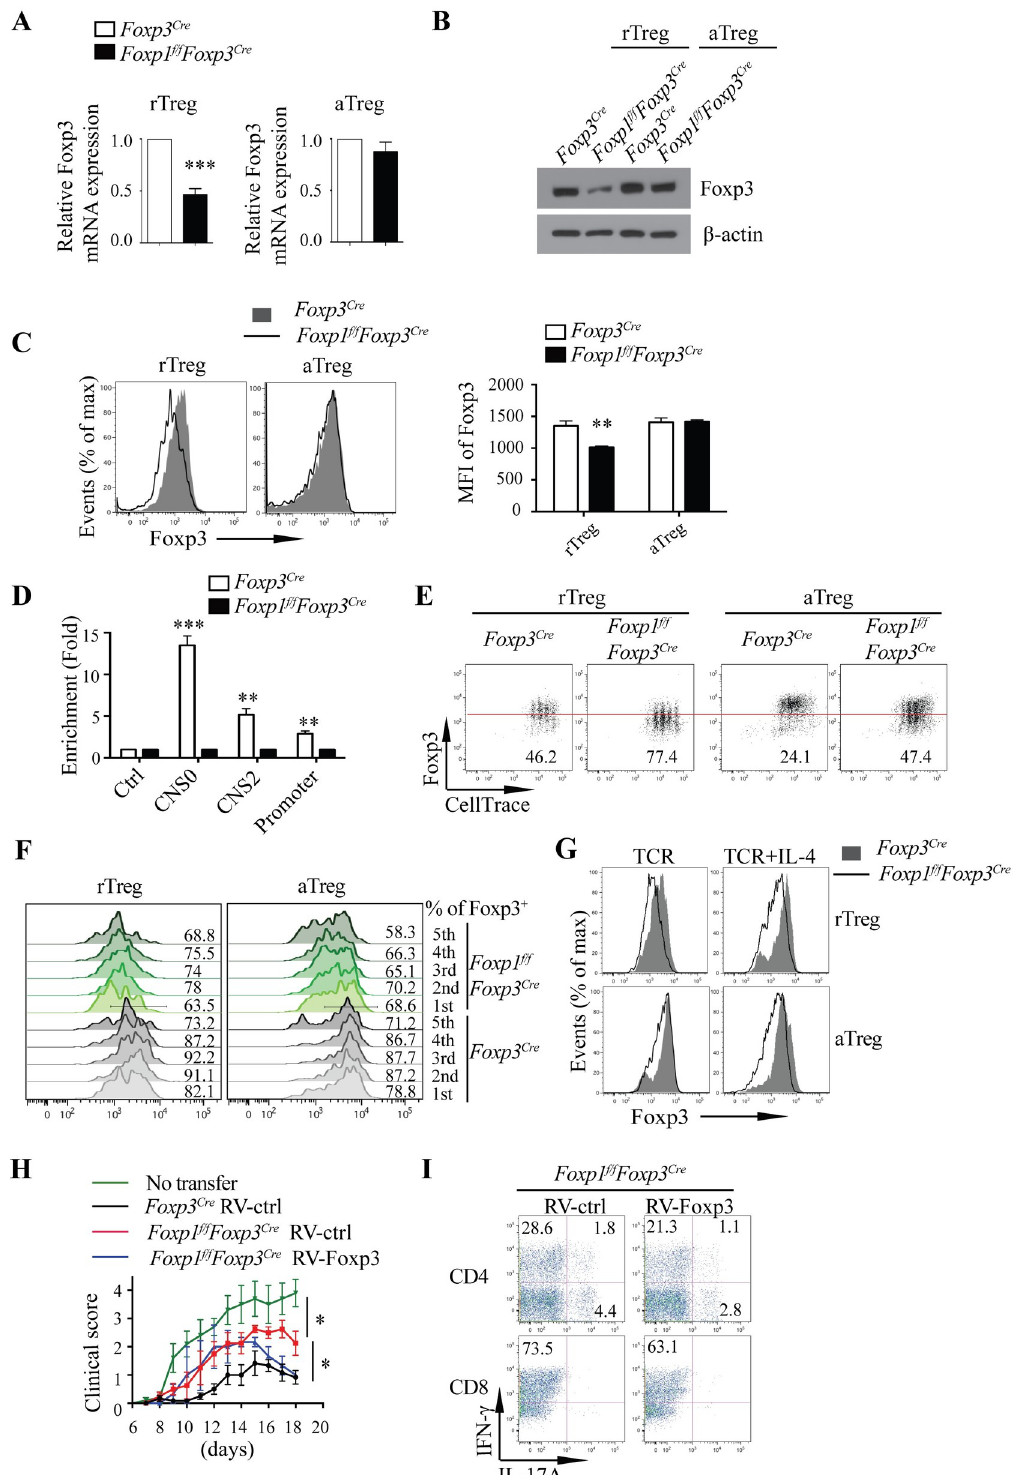
Fig 6. Foxp1 helps maintain Treg cell suppressive function through controlling stable Foxp3 expression. (A) Relative Foxp3 mRNA levels in highly purified rTreg ( n = 4) and aTreg cells ( n = 6) from Foxp3 Cre and Foxp1 f/f Foxp3 Cre mice. (B) Immunoblot analysis of Foxp3 in rTreg and aTreg cells from Foxp3 Cre and Foxp1 f/f Foxp3 Cre mice. (C) Flow cytometry analysis of the expression of Foxp3 in rTreg and aTreg cells from the spleens of Foxp3 Cre and Foxp1 f/f Foxp3 Cre mice (left panel), and the